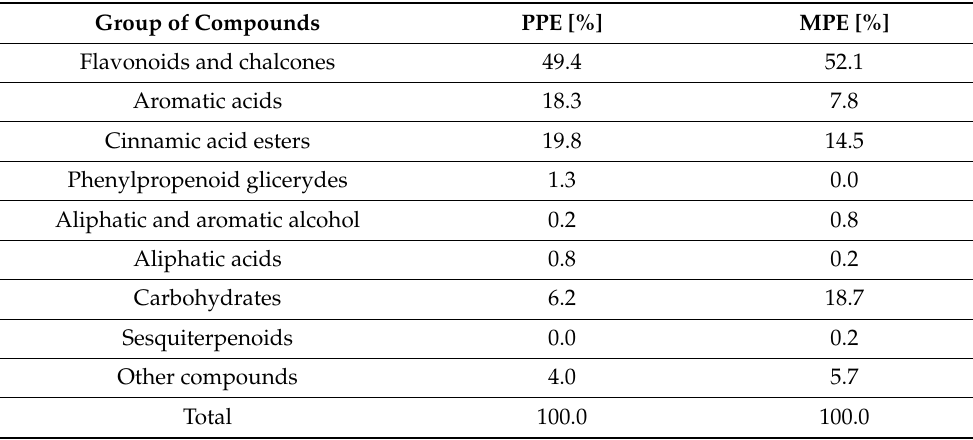
Table 3. Group composition of ethanolic extracts from Poland (PPE) and New Zealand (MPE) propolis. Group of